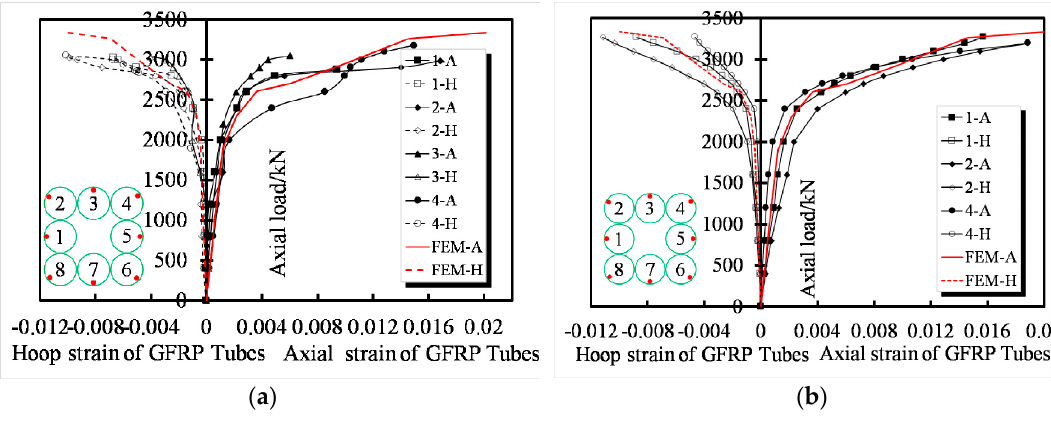
( b ) Figure 13. Comparisons of load-displacement curves: ( a ) specimen T8 and ( b ) specimen T8N. Table 6. Comparison of experimental and analytical results. N y (kN)